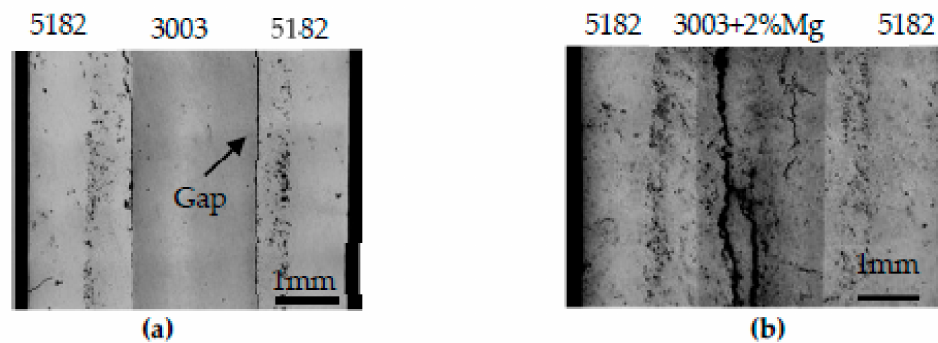
Figure 13. Cross-section of as-cast clad strips. ( a ) 5182/3003/5182 clad strip, ( b ) 5182/3003 + 2% Mg/5182 clad